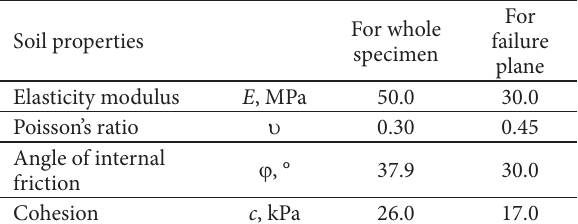
Table 4. Soil strength parameters Soil properties